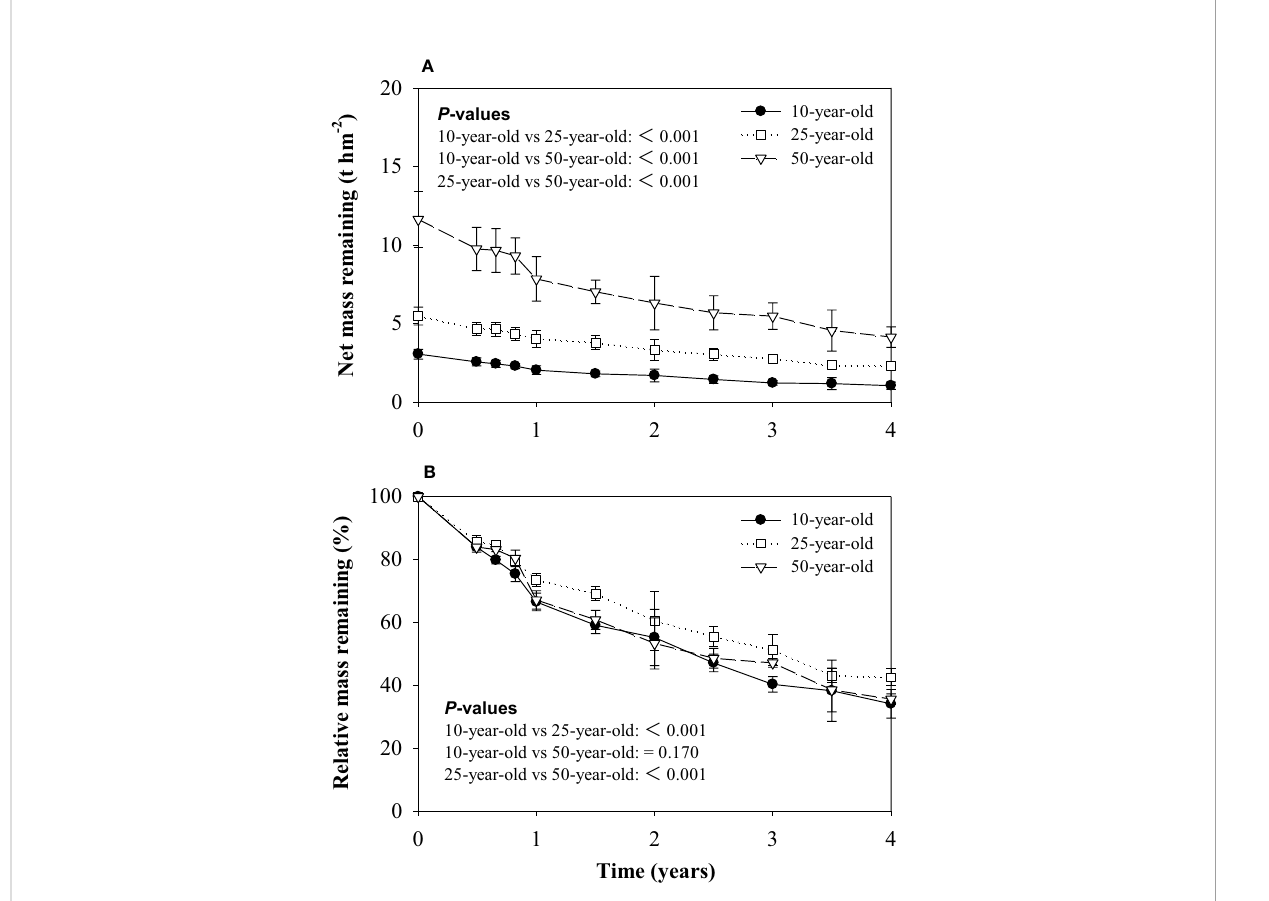
FIGURE 1 Net mass remaining (A) and relative mass remaining (B) of litter during decomposition in experiment 1. P -values for effects of stand ages are obtained by linear mixed